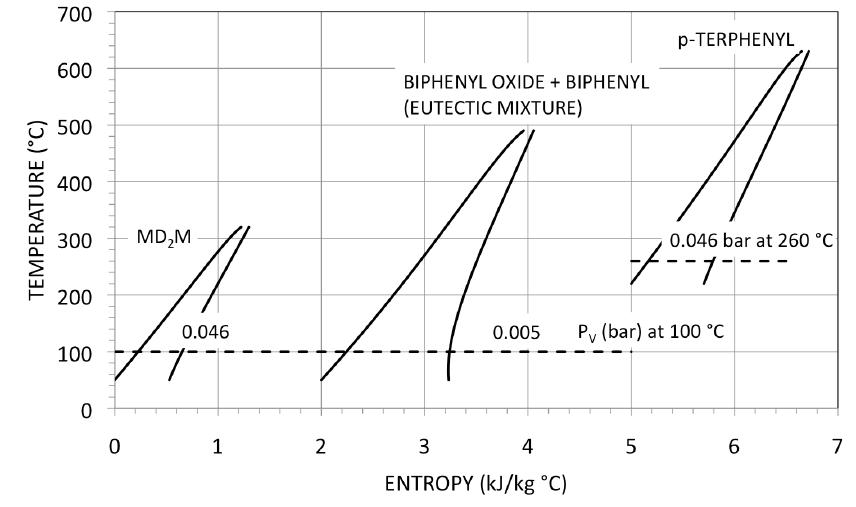
Figure 2. Dew and bubble lines of the considered working fluids in the Temperature-Entropy plane.